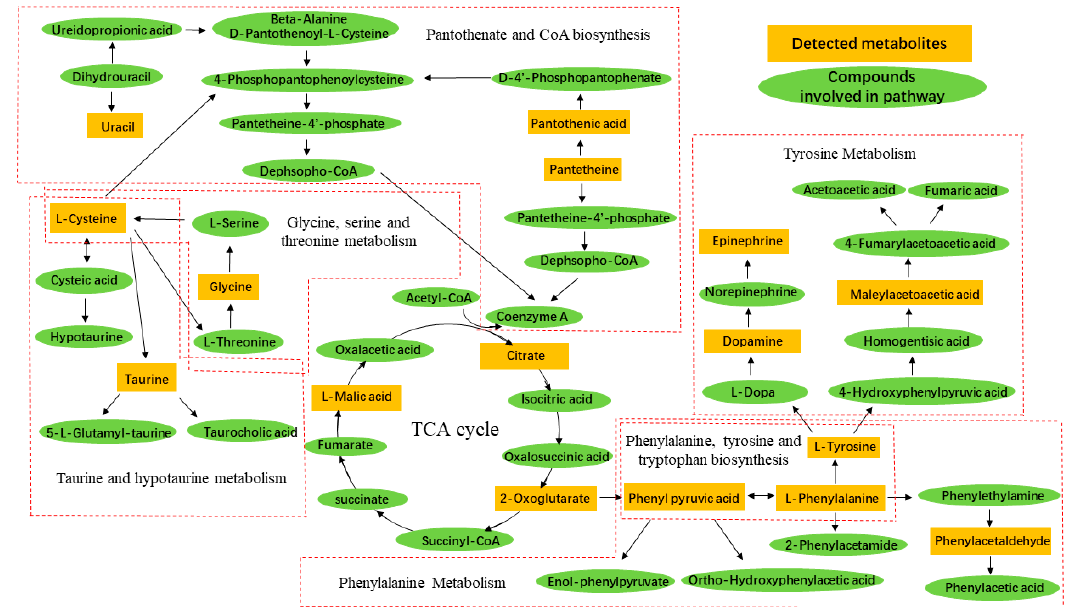
Figure 9. Related metabolic pathway.